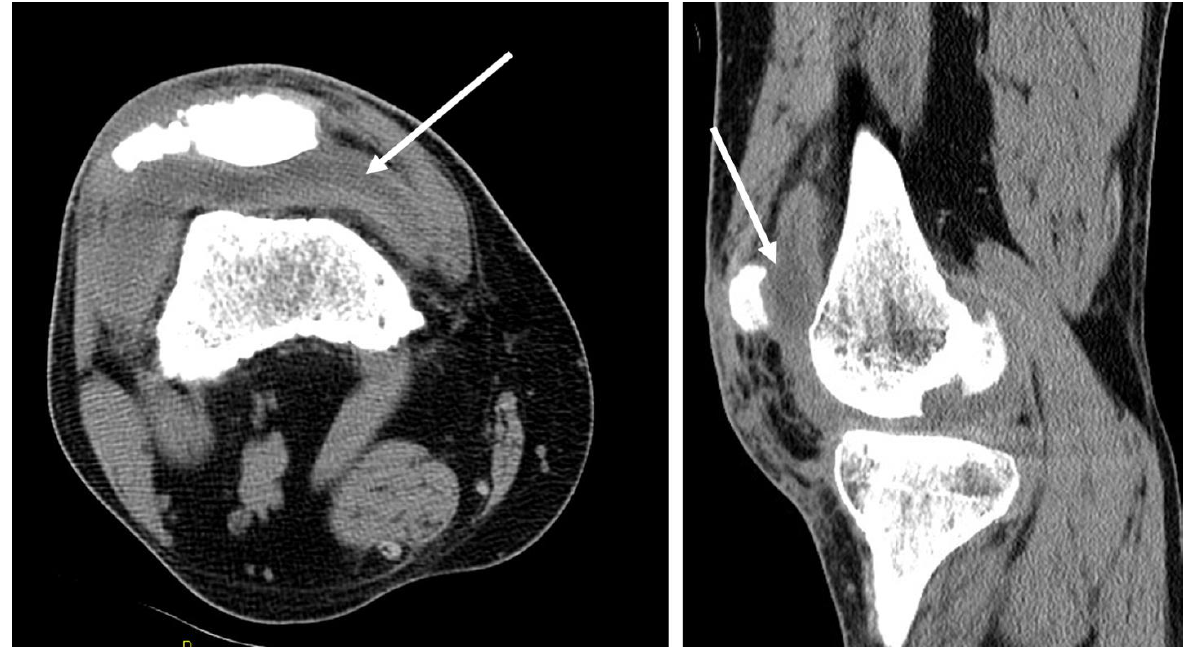
Figure 7. CT without contrast of R knee. Moderate suprapatellar joint effusion of right knee. ( Left ): Transverse view shows some extension of effusion laterally. ( Right ): Sagittal view shows some extension inferiorly.